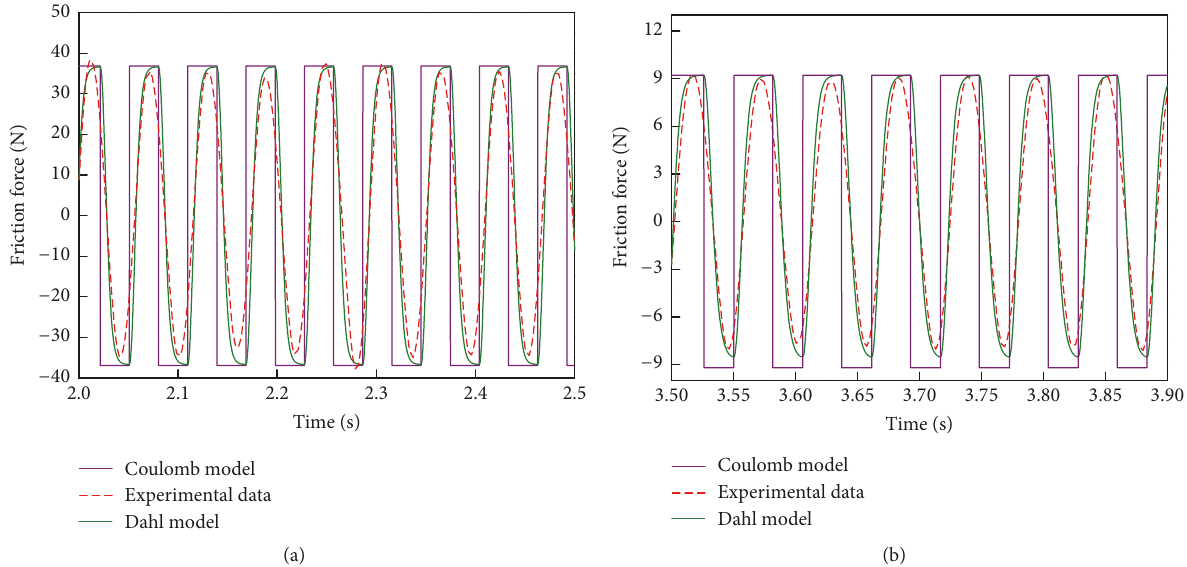
Figure 7: Comparison between the numerical simulation and experimental results: (a) dry, 𝑢 = 5mm, 𝑓 = 17Hz, V 𝑑 = 60 mm/s, and 𝐹 𝑁 = 90 N; (b) OBM, 𝑢 = 4 mm, 𝑓 = 20Hz, V 𝑑 = 60mm/s, and 𝐹 𝑁 = 30 N.